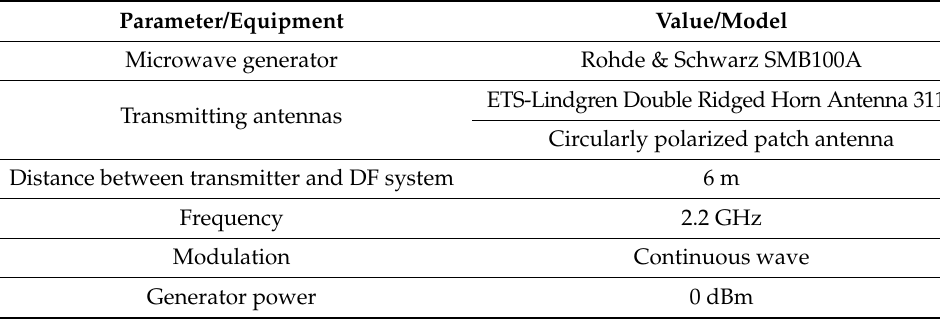
Table 3. Experimental setup and equipment.